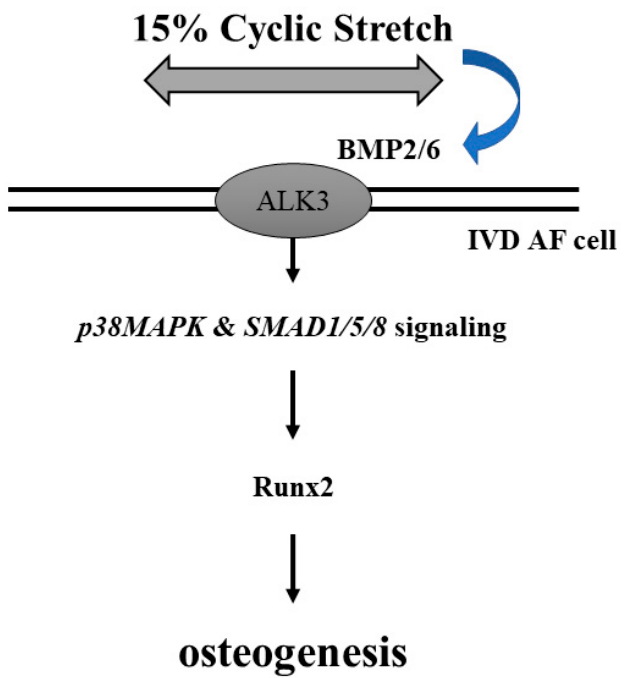
Figure 9. Schematic representation of a possible mechanism affecting 15% cyclic stretch-induced BMP-2/6 expression and consequent osteogenesis regulations in human AF cells.